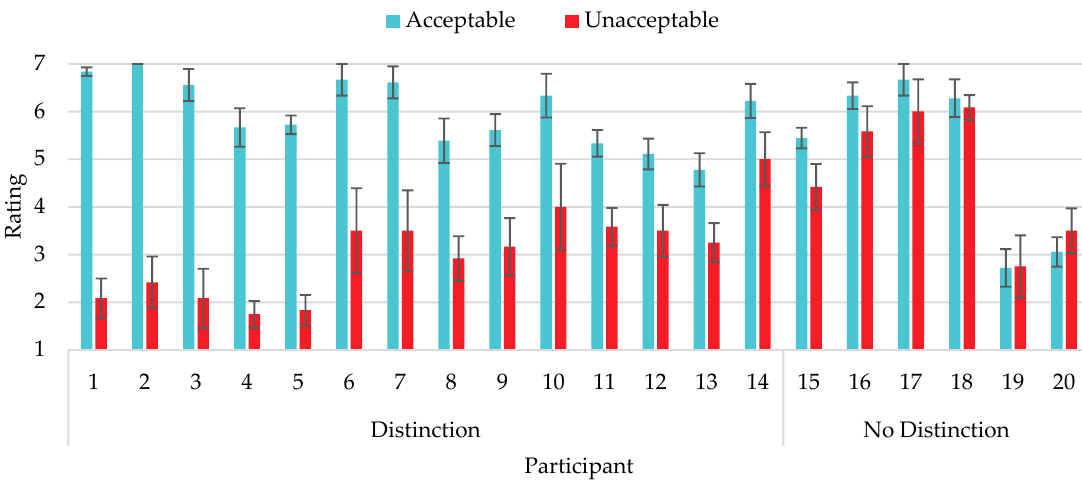
Figure 2. Mean rating of control stimuli by participant and stimulus type.